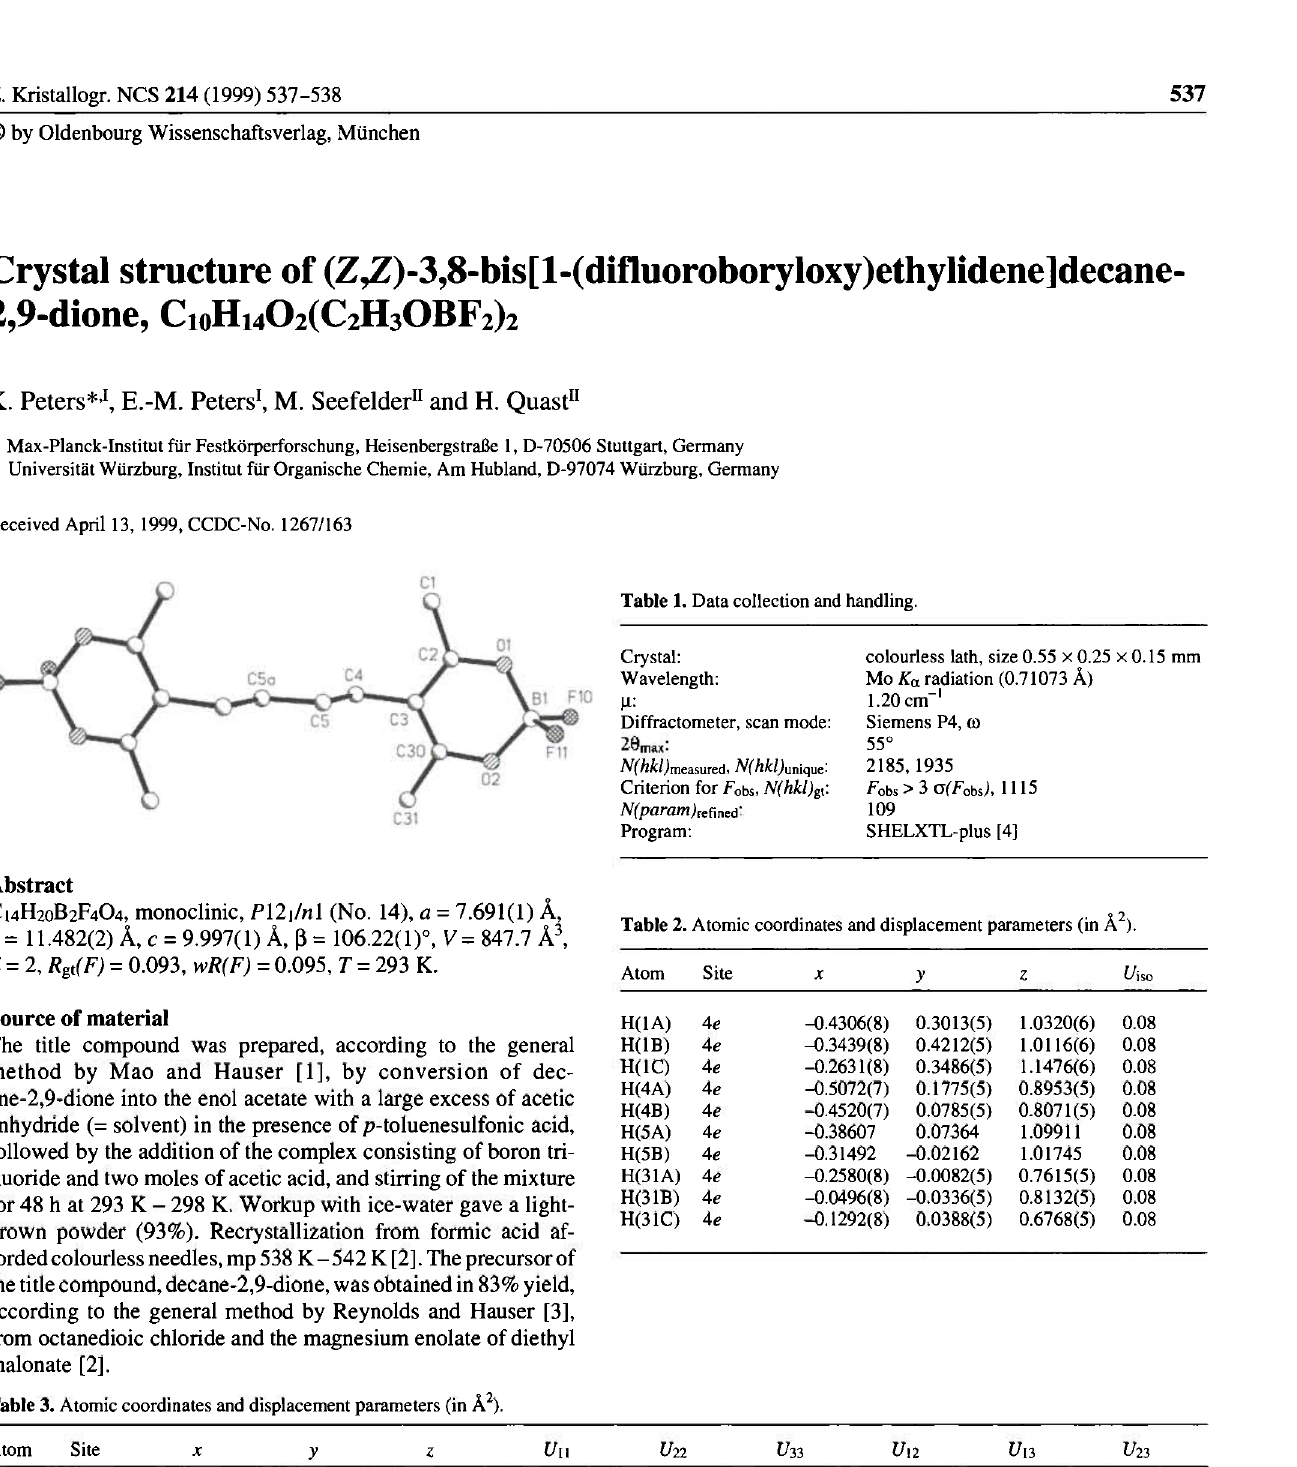
Table 3. Atomic coordinates and displacement parameters (in Ä 2